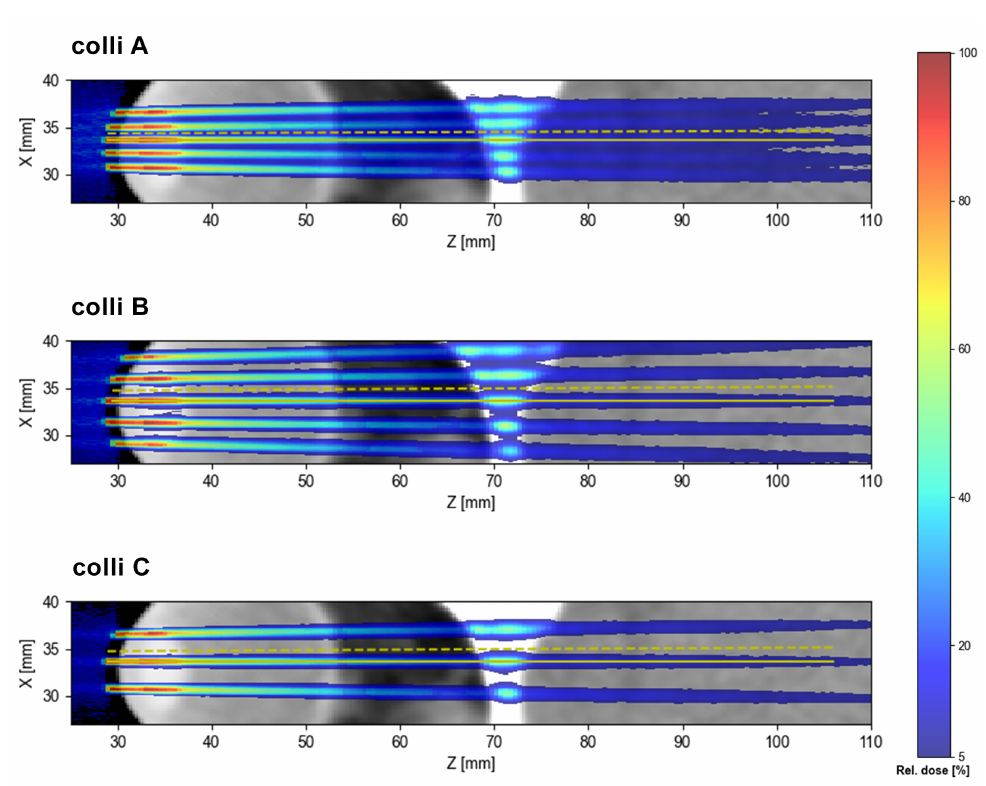
Figure 6. Minibeam dose patterns obtained with the three collimator geometries A, B and